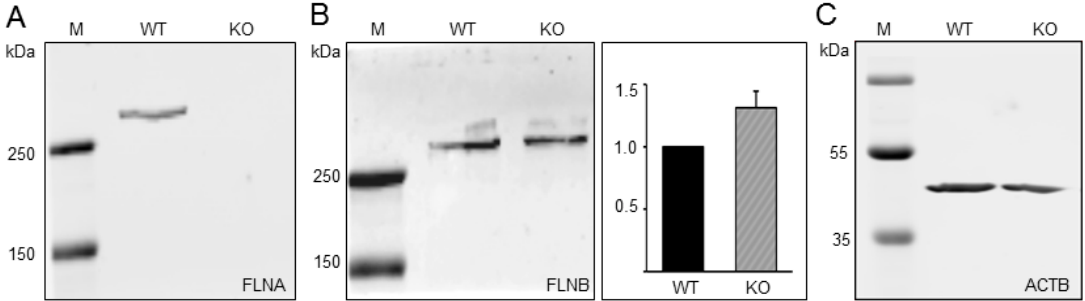
Figure 3. Western blot analysis of FLNA-deficient TCam-2 cells generated by CRISPR/Cas9 technology. ( A ) Cell lysates prepared from TCam-2 wildtype (WT) and FLNA-deficient (KO) cells were